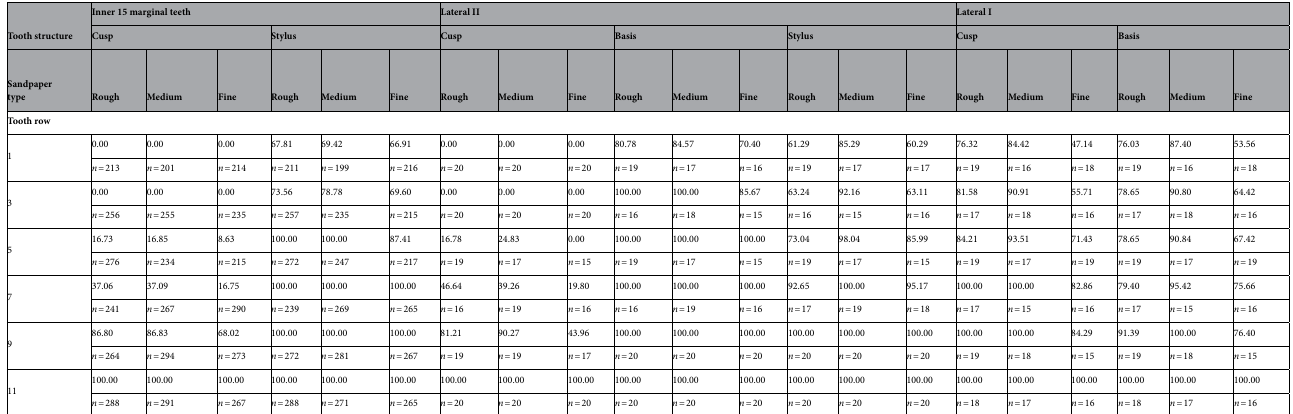
Table 2. Mean tooth areas of the tooth parts (cusp, stylus, basis) still present in every second row (tooth row 1 = outermost row [oldest and most frequently used one]; tooth row 11 = first [youngest] row with almost no signs of wear) after foraging on sandpaper (rough, medium, fine), in %. n = analyzed teeth for area loss